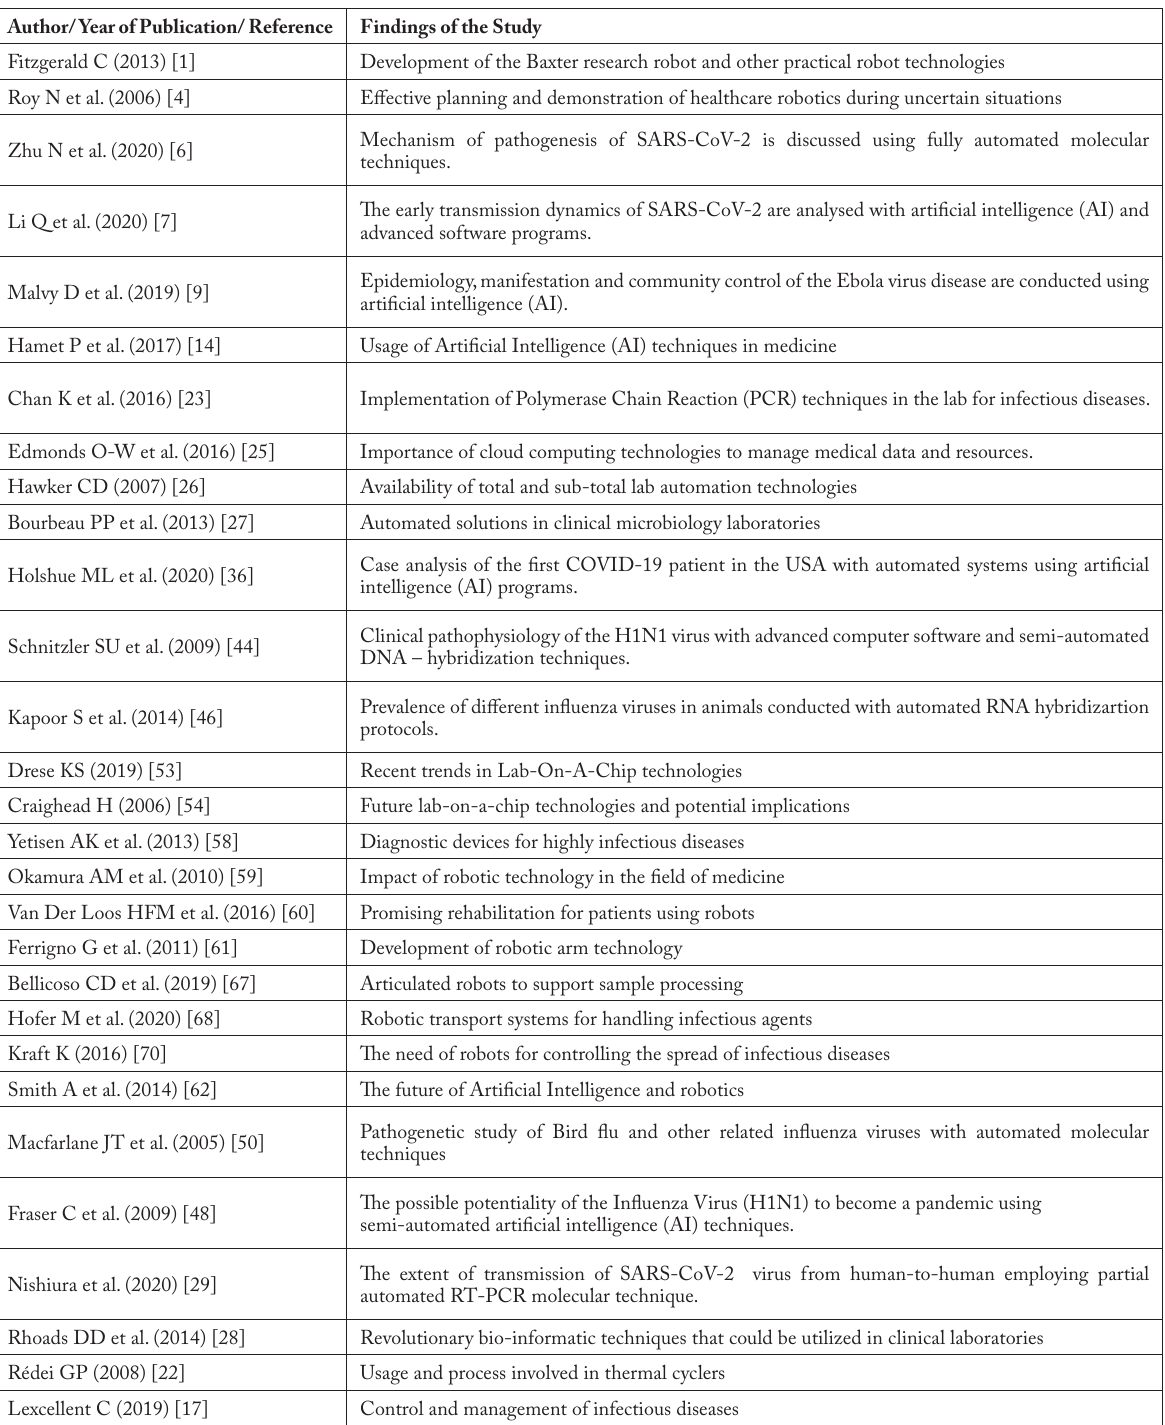
Table 1. Main findings of the included